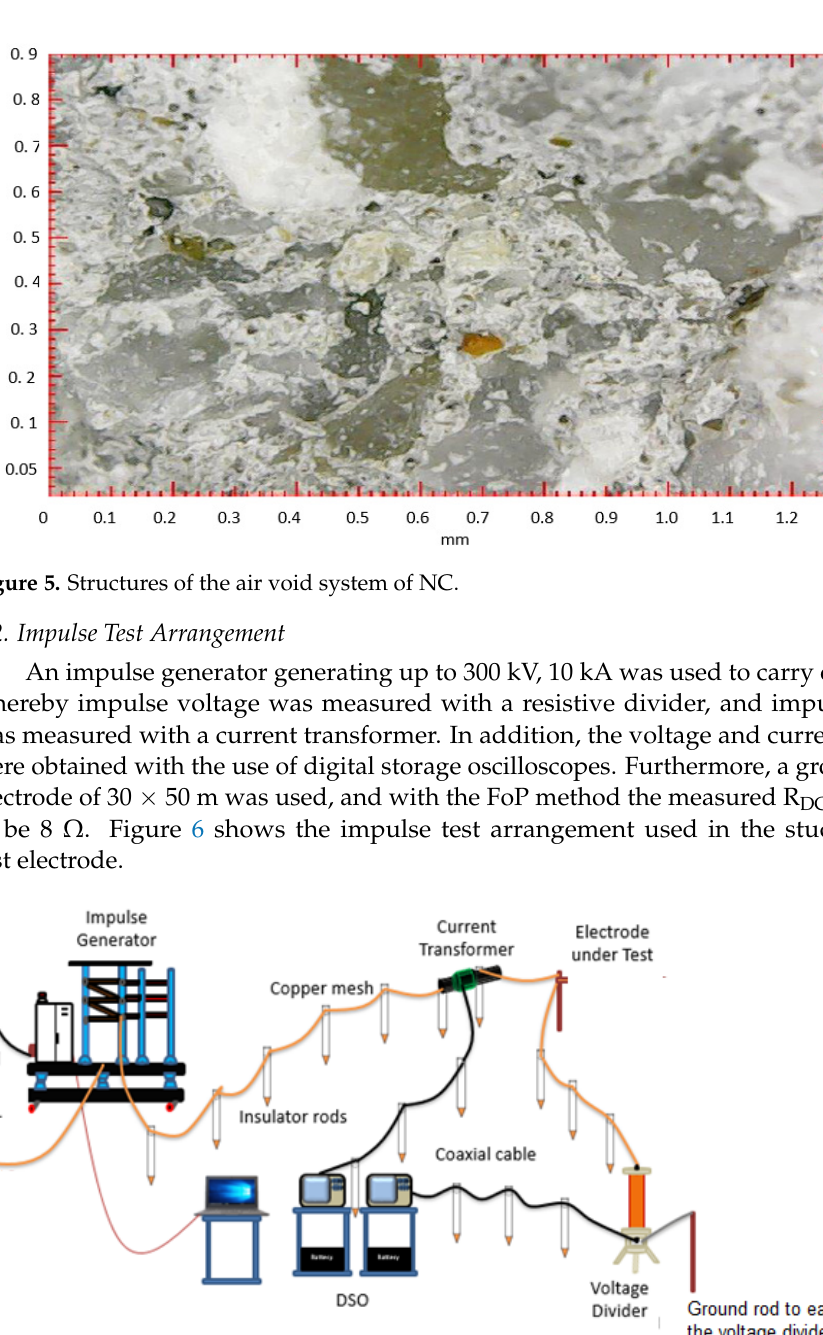
Figure 6. Impulse test arrangement .